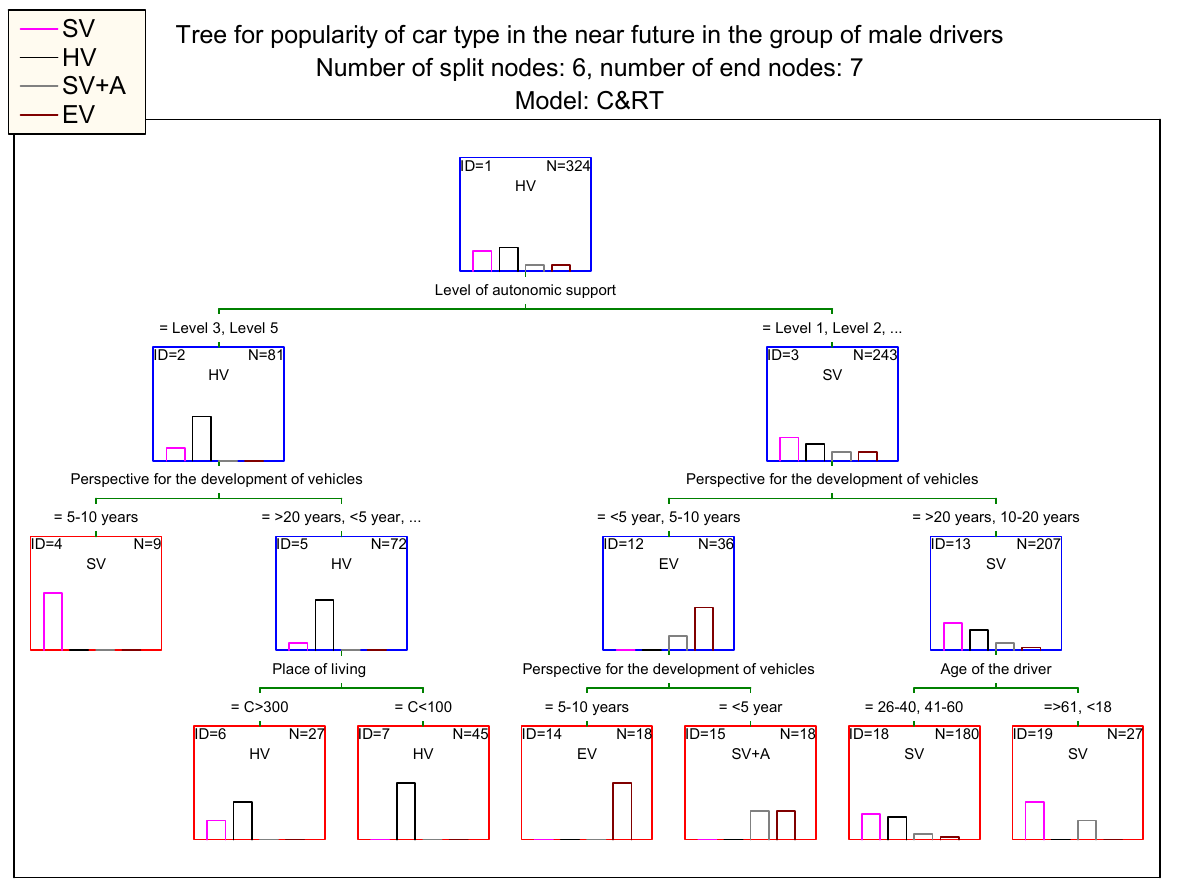
Figure 7. C&RT for the relationship between the popularity of individual types of systems used in passenger cars in the opinion of men, depending on such dependent variables as the level of vehicle autonomy, age of the driver, place of residence and the time when these cars will be popular in the future.